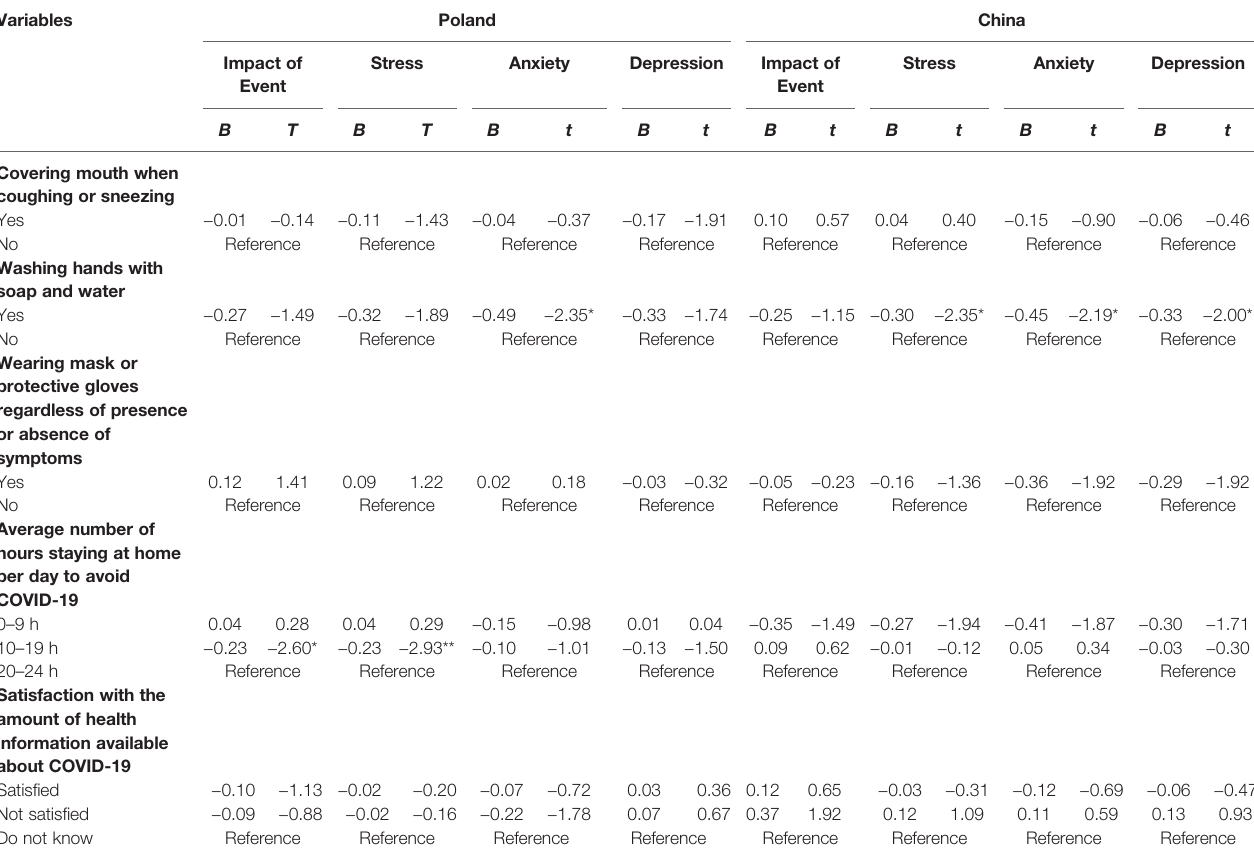
TABLE 6 | Comparison between associations of precautionary measures in the past 14 days, health information and the psychological impact of the 2019 coronavirus disease (COVID-19) outbreak, as well as adverse mental health status between Polish and Chinese respondents during the epidemic with adjustment for age, gender, and education (N =